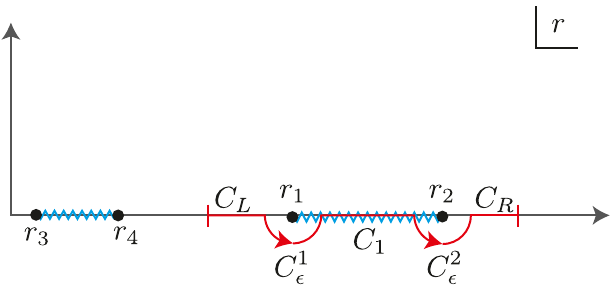
Figure 2 . Branch cut structure of the integral (A.13). This integral has two branch cuts that connect the points r 1 to r 2 and r 3 to r 4 . The piece over C 1 the parts over C L and C R are completely